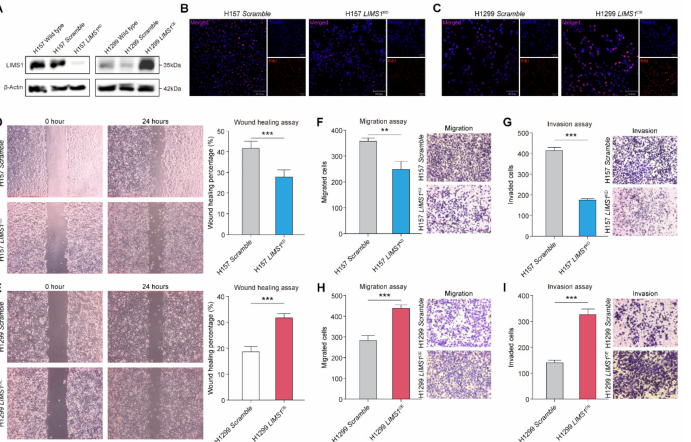
Figure 7. The role of LIM and senescent cell antigen-like domain 1 (LIMS1) in the regulation of non-small-cell lung cancer (NSCLC) progression. ( A ) The effect of LIMS1 knockdown or overex- pression was verified with Western blotting. ( B , C ) EdU assay measured the effects of LIMS1 on the proliferation potential of NSCLC cells. The images were measured under 100 × magnification. ( D , E ) The wound-healing assay measured the effects of LIMS1 on the migratory potential of NSCLC cells. The images were measured under 40 × magnification. ( F – I ) The transwell assay measured the effects of LIMS1 on the migration and invasion potential of NSCLC cells. The images were measured under 100 × magnification. ** p < 0.01; *** p <